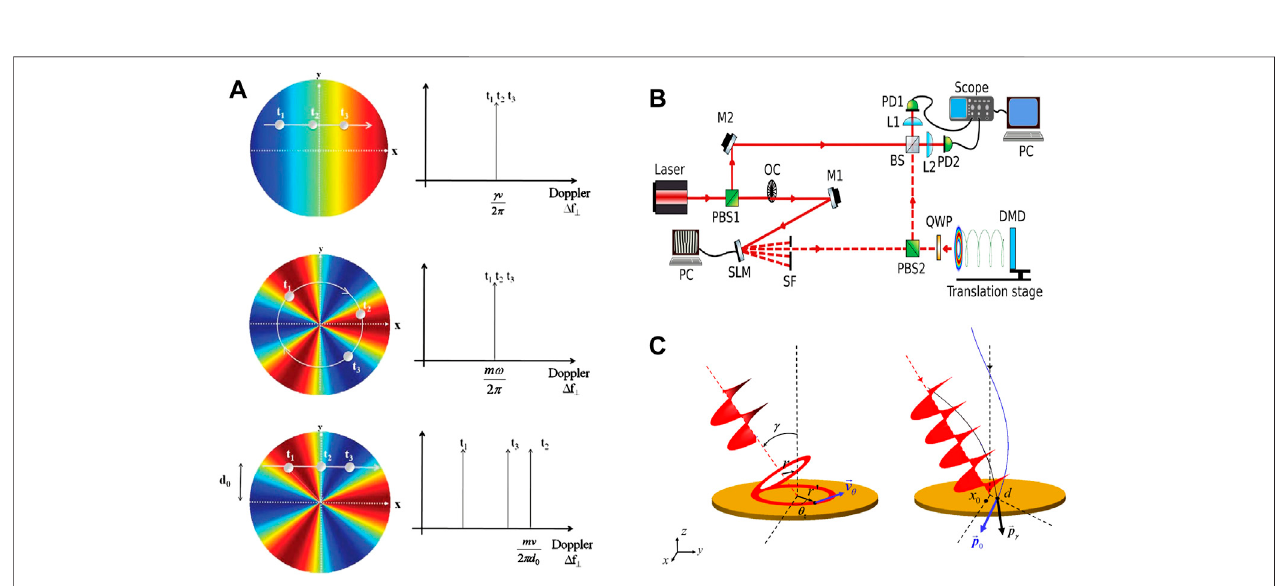
FIGURE2|(A) TheproductionofDopplereffectwithstructuredlight[37]. (B) Compoundmotiondetectionscheme[38]. (C) RotationalDopplereffectatvortexlight oblique incidence